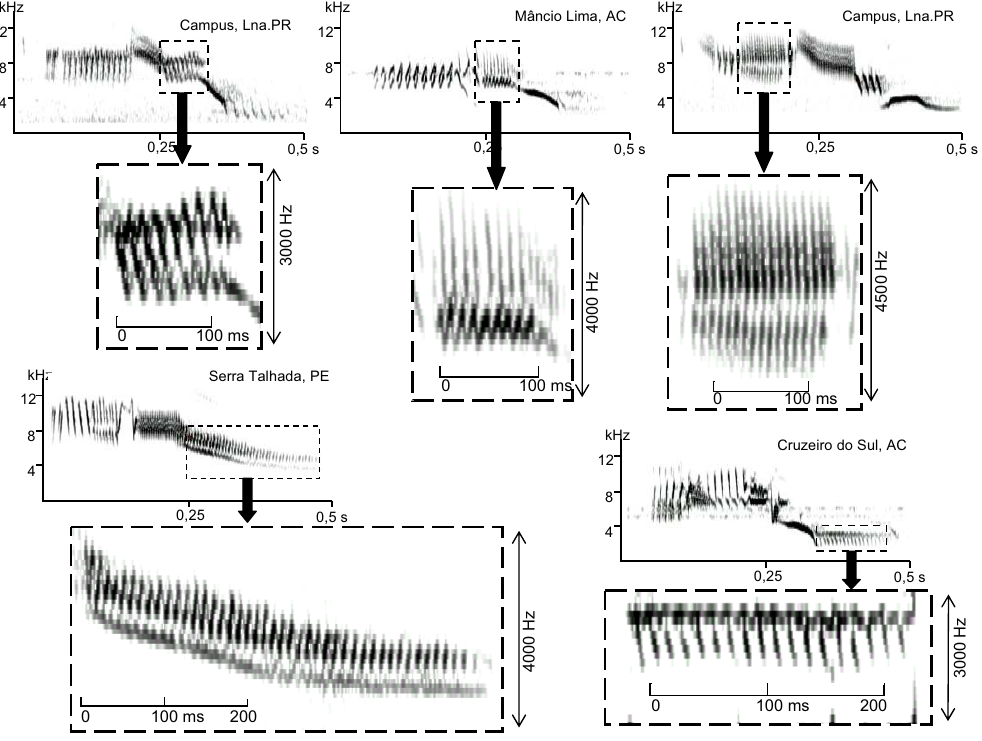
Fig. 8 – Examples of Double Voices on Vibrations: the ‘‘Zipper Effect’’ as shown in the enlarged inserts.